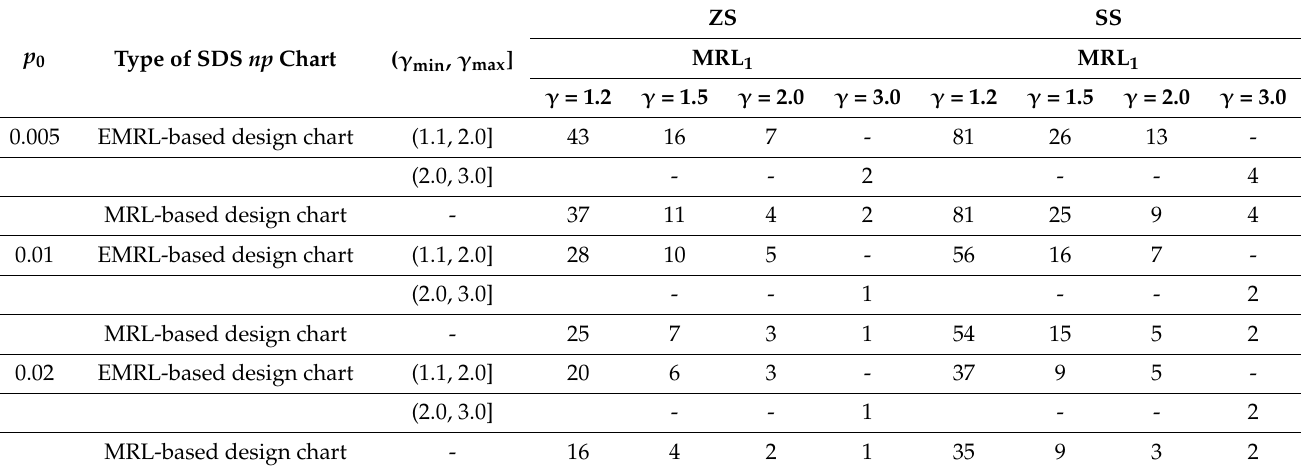
Table 6. MRL 1 values computed using the optimal charting parameters of the EMRL-based SDS np chart and the MRL-based SDS np chart for n = 100 and MRL 0min =